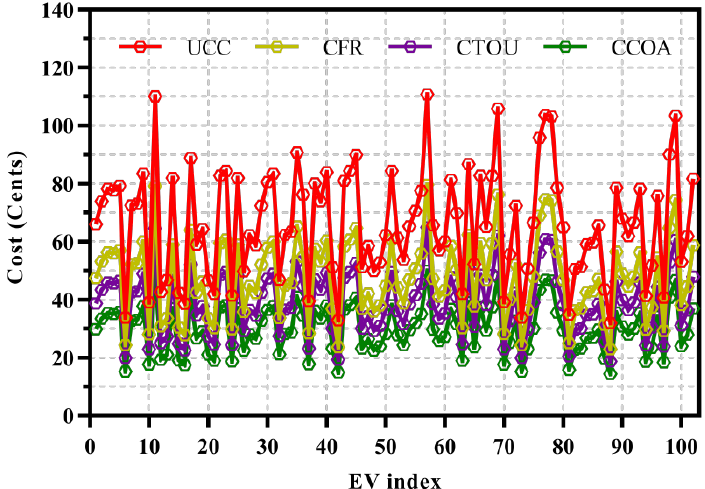
Figure 13. Charging cost of EVs concerning UCC, CFR, CTOU, and CCOA